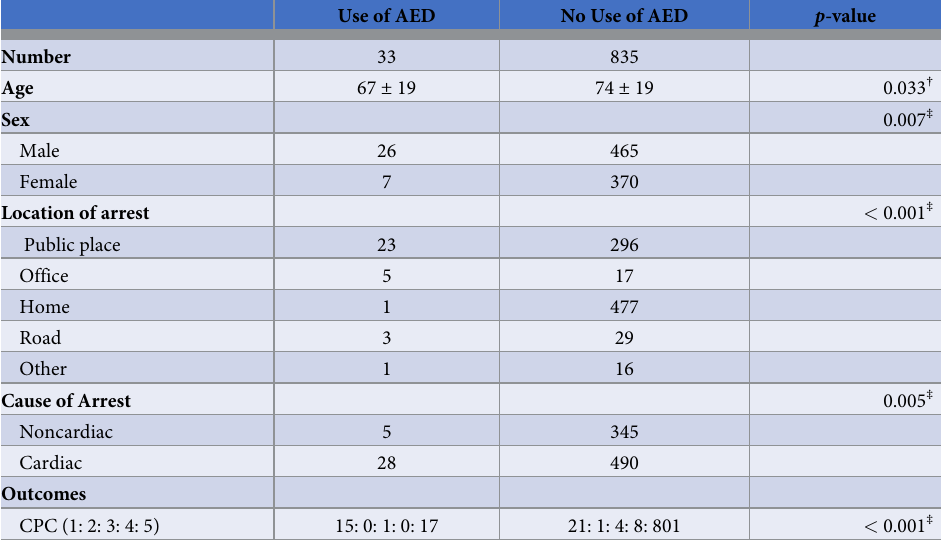
Table 4. Background of patients with OHCA who were given defibrillation with public-access AED. Use of